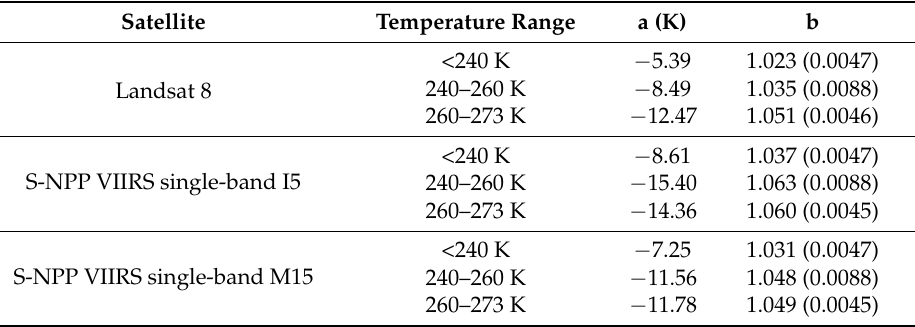
Table 2. Suomi National Polar-orbiting Partnership (S-NPP) Visible Infrared Imaging Radiometer Suite (VIIRS) and Landsat 8 single-band ice surface temperature retrieval coefficients and the standard errors (in parenthesis) of the coefficients in the Arctic as in Equation (2).